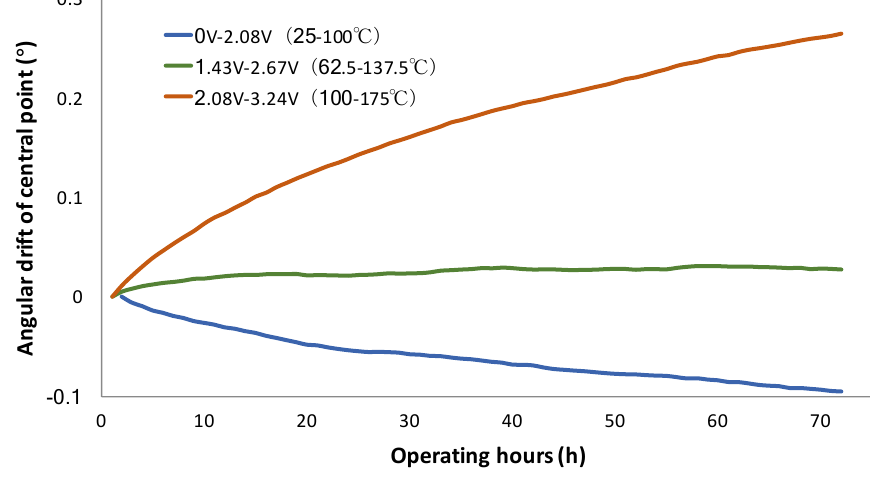
Figure 8. The angular drift of MEMS mirror scanning driven by AC signals as a function of operating